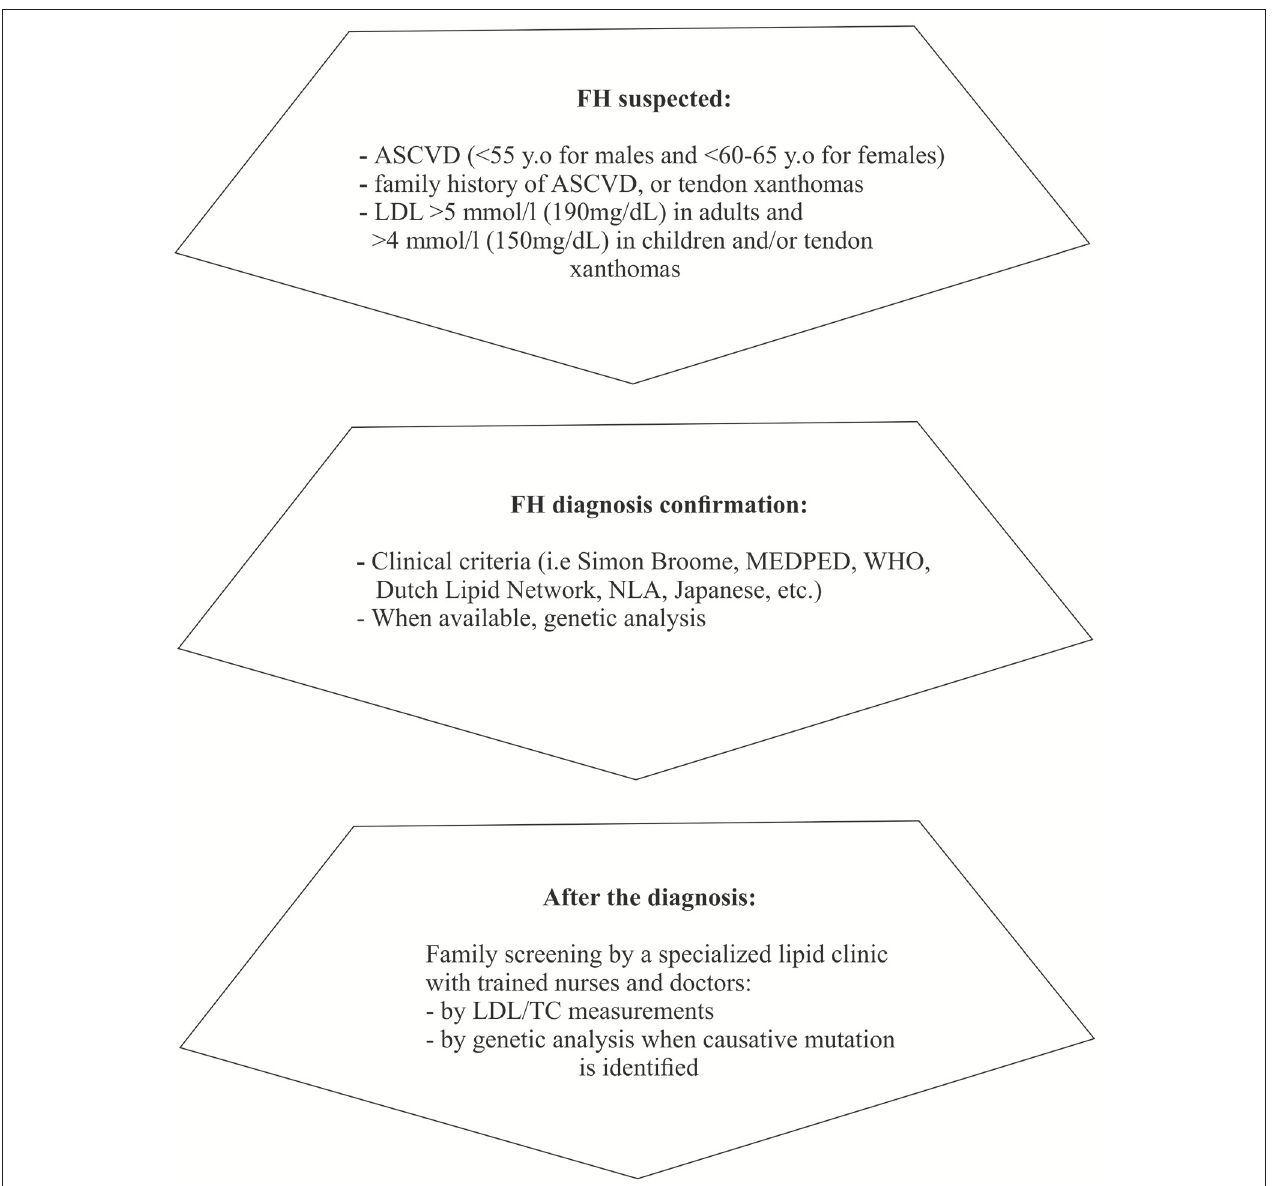
FIGURE 1 | Diagnostic approach/steps for suspected FH (based on Catapano et al., 2016; Jellinger et al., 2017). ASCVD, Atherosclerotic cardiovascular disease; LDL, Low density lipoprotein; MEDPED, Make early diagnosis to prevent early death; WHO, World health organization; NLA, National lipid association; LDL, Low density lipoprotein; TC, Total